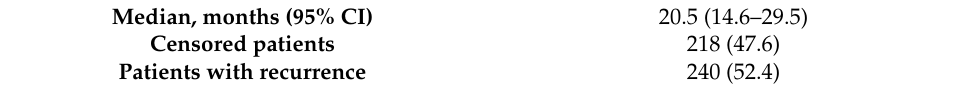
Figure 3. Kaplan–Meier curves showing the probability of not having recurrence at 5 years in the overall population made up of eNSCLC patients with chemotherapy after surgery in stage II–IIIA (study period January 2015–June 2021). Table 3. Patients with recurrence and median time to recurrence.